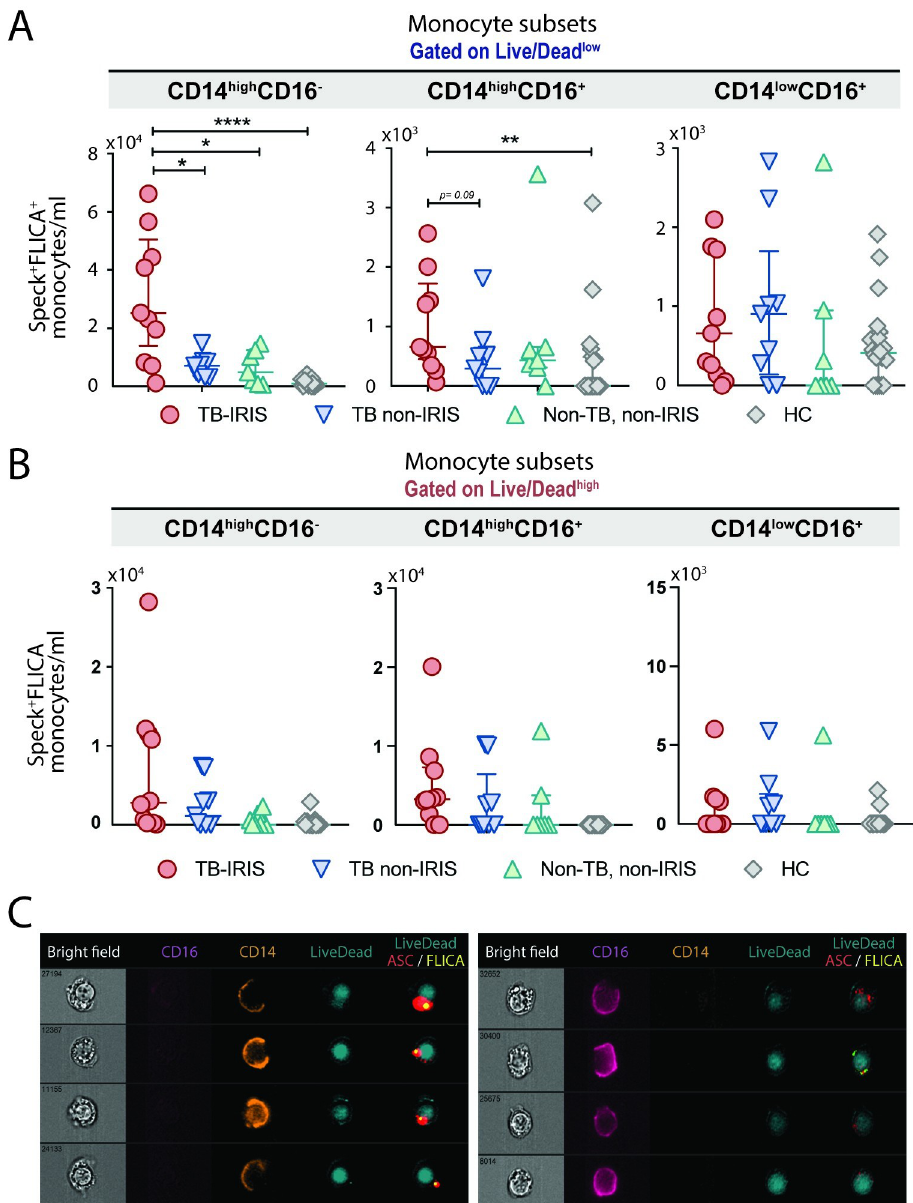
Fig 3. Quantification of canonical inflammasome activation within distinct monocyte subsets in different stages of pyroptosis. FLICA + ASC-speck + monocytes/ml were quantified in PBMCs from healthy volunteers and patients after modulation_morphology (M11,Ch11),11-ASC, followed by bright detail similarity R3_MC_11-ASC_2-FLICA features were applied in all data points, inside Live/Dead AQUA low ( A ) or Live/Dead AQUA high ( B ) gates. � P < 0.05, �� P < 0.01 and ���� P < 0.001, when Mann-Whitney test was applied. ( C ) Representative images of FLICA + ASC- speck + monocytes inside the Live/Dead AQUA high gate within CD14 high CD16 - subset (left panel) or CD14 low CD16 + subset (right panel) were selected, showing respectively: BF1 (brightfield), CD16, CD14, Live/Dead (L/D) and a composite image containing the fluorescence of Live/Dead AQUA, FLICA and ASC. non-IRIS groups, post-ART (mC1q: TB-IRIS, median of 1.521 fold change [IQR: 1.376–1.724] vs TB non-IRIS 1.219 [IQR: 1.147–1.326] and mC3: TB-IRIS, median of 3.730 fold change [IQR: 2.445–4.952] vs TB non-IRIS 2.203 [IQR: 1.396–2.535]).